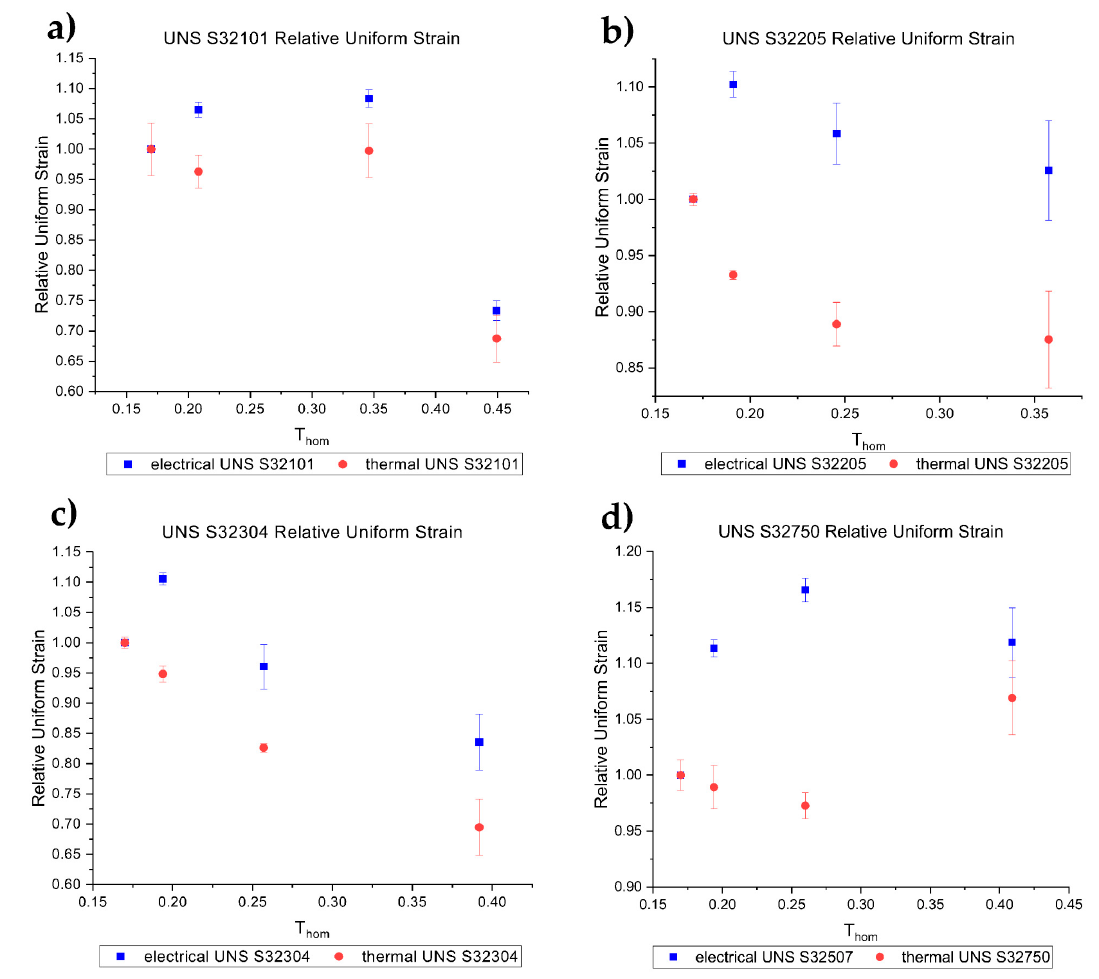
Figure 9. Relative uniform elongation of the different DSS grades. Red circles refer to the thermal test while the blue dots to the electrical test. UNS S32101 ( a ), UNS S32205 ( b ), UNS S32304 ( c ) and UNS S32750 ( d ).